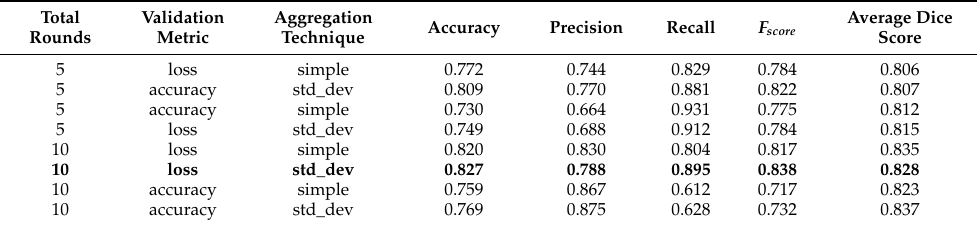
Table 4. Results of server-centric federated semi-supervised transfer learning experiments with an initial model obtained through training 15 epochs. The best performance is highlighted in